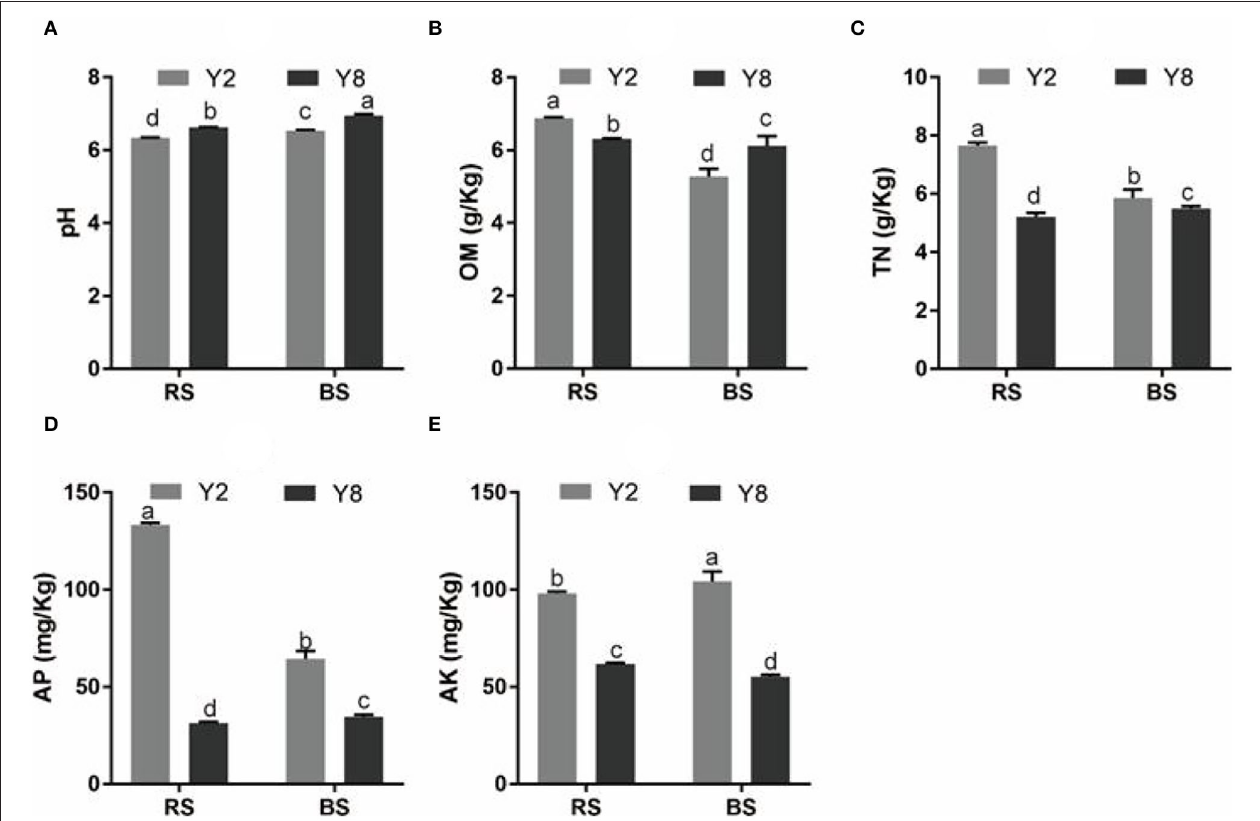
FIGURE 2 | A comparison of soil physicochemical properties of rhizosphere and bulk soil of continuous cropping of stevia for 2 and 8 years. (A) pH. (B) OM. (C) TN. (D) AP. (E) AK. pH, pH value; OM, organic matter; TN, total nitrogen; AP, available phosphorus; AK, available potassium. Y2, 2 years of continuous cropping; Y8, 8 years of continuous cropping; Y2.RS, rhizosphere soil of 2 years of continuous cropping; Y8.RS, rhizosphere soil of 8 years of continuous cropping; Y2.BS, bulk soil of 2 years of continuous cropping; Y8.BS, bulk soil of 8 years of continuous cropping. The different lowercase letters in the same column indicate significant differences between different treatments ( p <